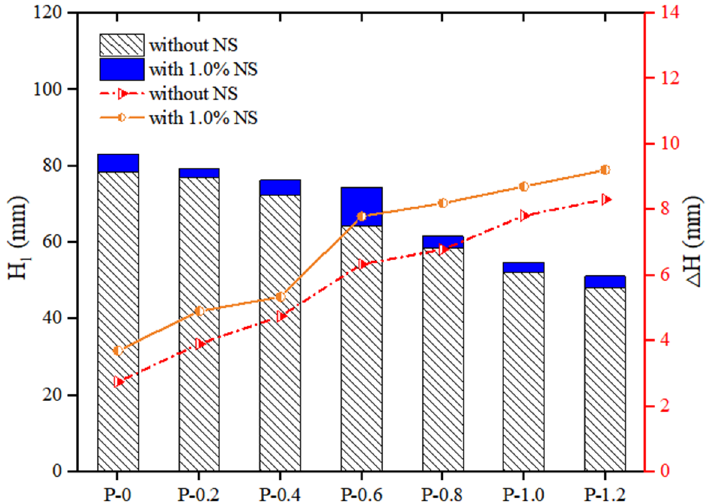
Figure 5. Influence of PVA fibers on thixotropy of geopolymer composites.